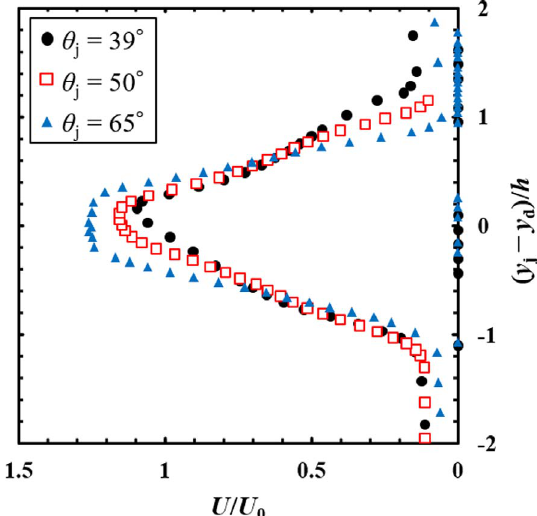
Figure 16. Time averaged velocity pro fi les at x j / h = 1, where vertical axes show relative height to jet displacement. ( y j,e = 0, l / h = 5.6, Q = 16 L/min).